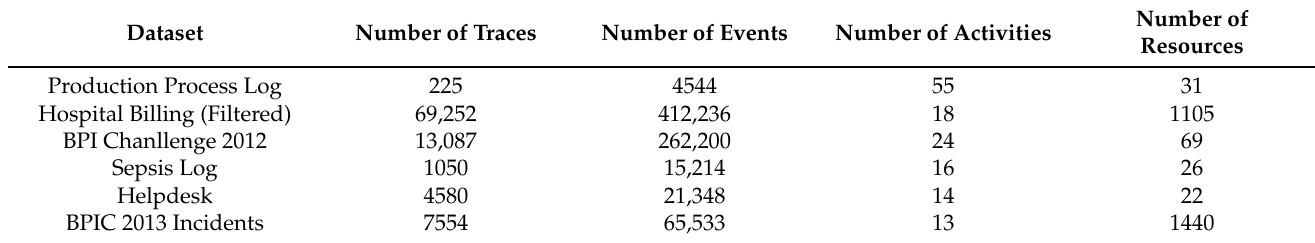
Figure 6. Pre-processing publicly available datasets to evaluate our method. Table 5. Characteristics of the used publicly available